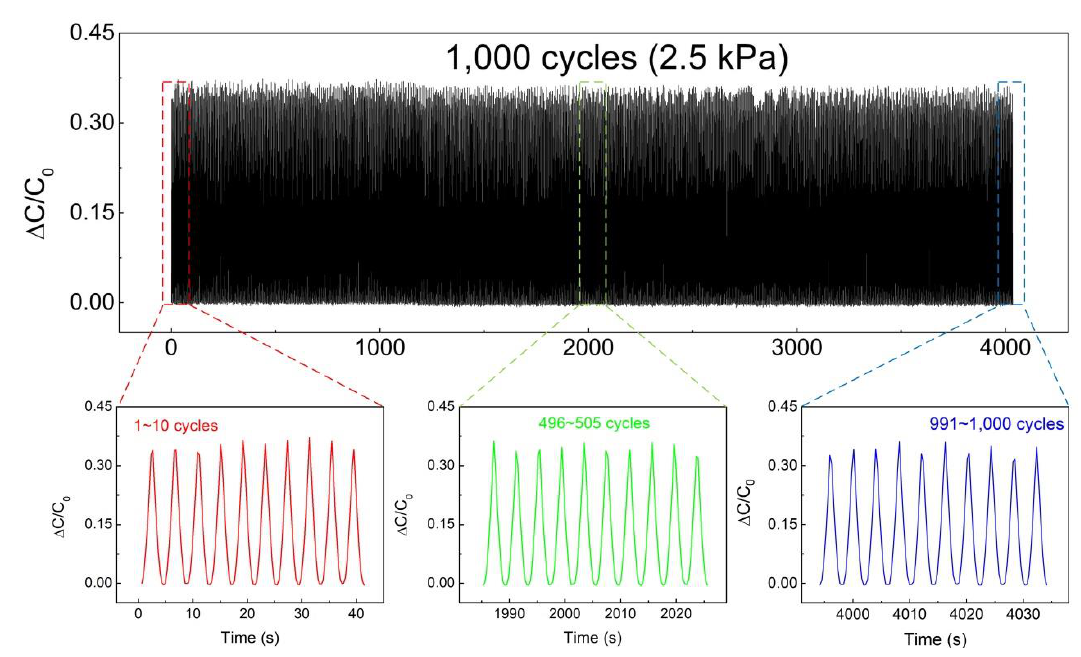
Figure 6. Reliability test results of the pressure sensor over 1000 cycles with measurement capacitance values. The red, green, and blue graphs show measurement results of the initial, middle, and final 10 cycles, respectively.